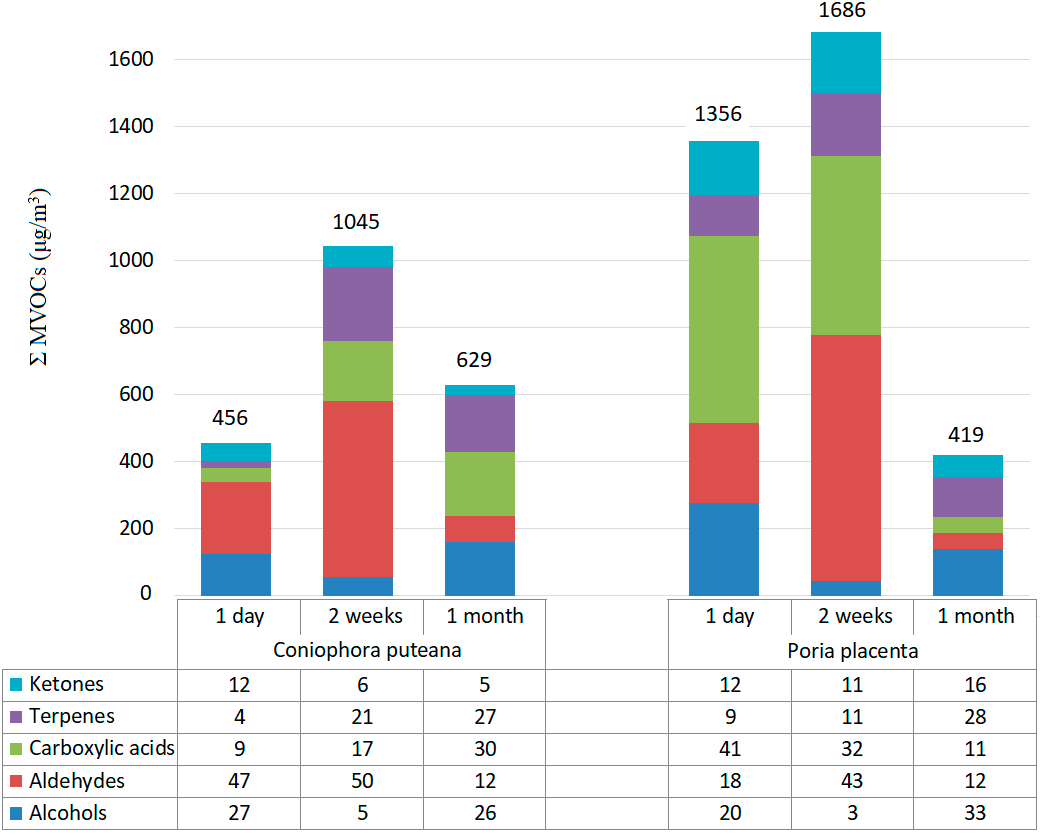
Figure 4. Concentration of Σ MVOCs (µg/m 3 ) emitted from Coniophora puteana and Poria placenta growth on maltose agar medium (numerical values above the bars) and percentage of MVOC constituents for these species throughout the monthly incubation period (table below the chart).